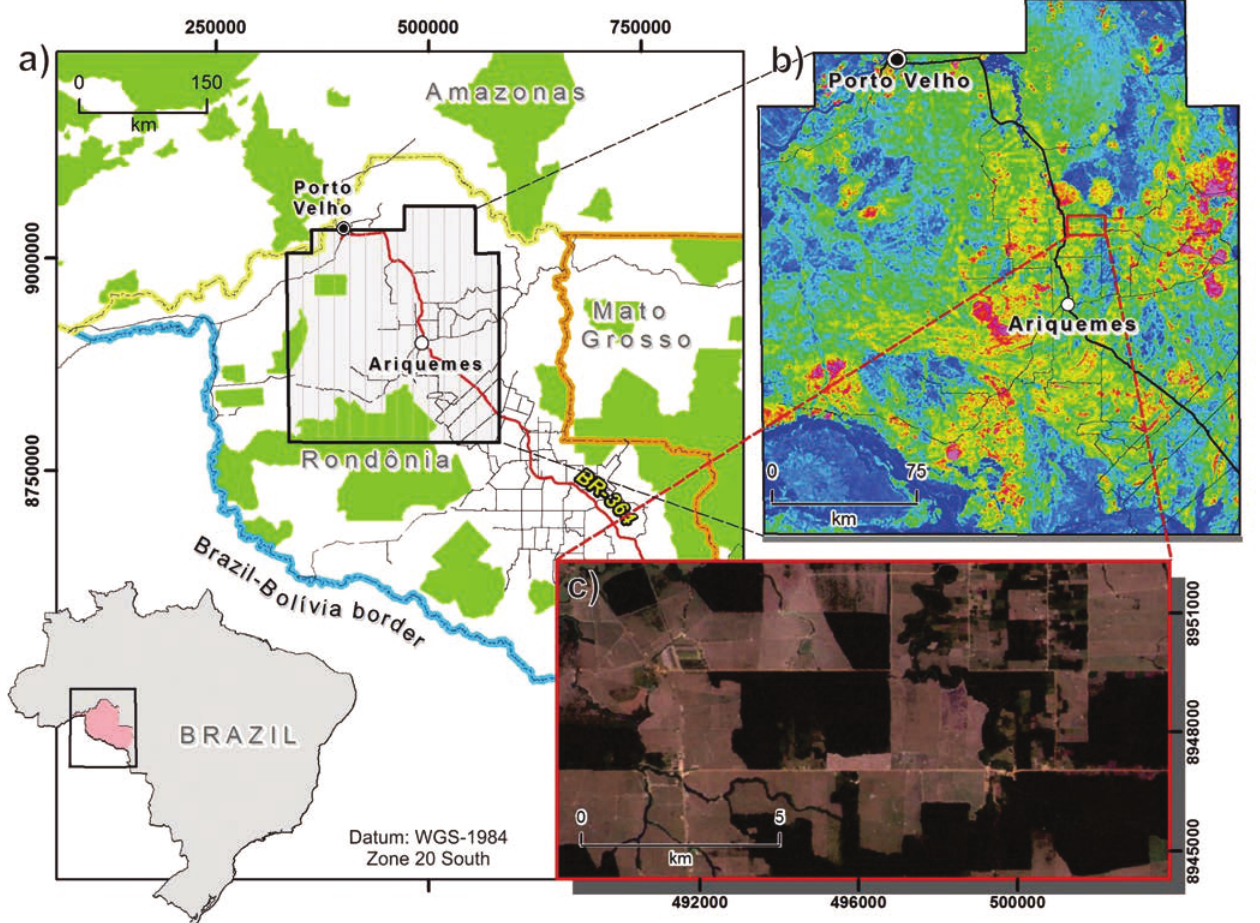
Figure 1 - a) Location of the airborne geophysical survey used in this work, in the central area of Rondônia State, northern Brazil. b) Total Count Radiation Map showing the localization of the study area. c) Detail of the study area in Landsat TM natural color composite showing the remaining area of natural vegetation and exposed soil, shrub and crop